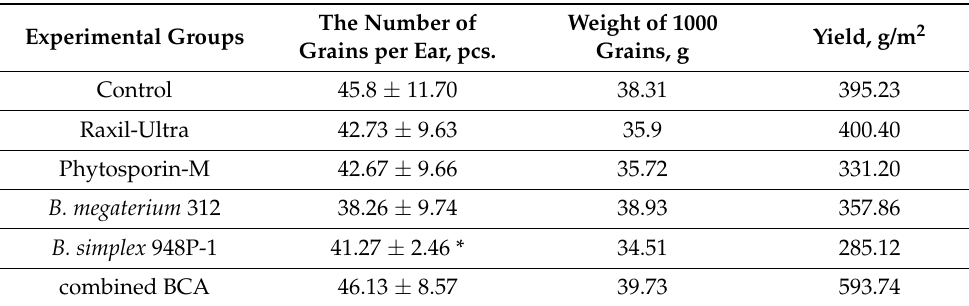
Table 3. The influence of the treatment of winter wheat seeds with various preparations and bacterial strains on the characteristics of